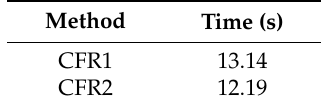
Table 5. Comparison of execution time (in seconds).